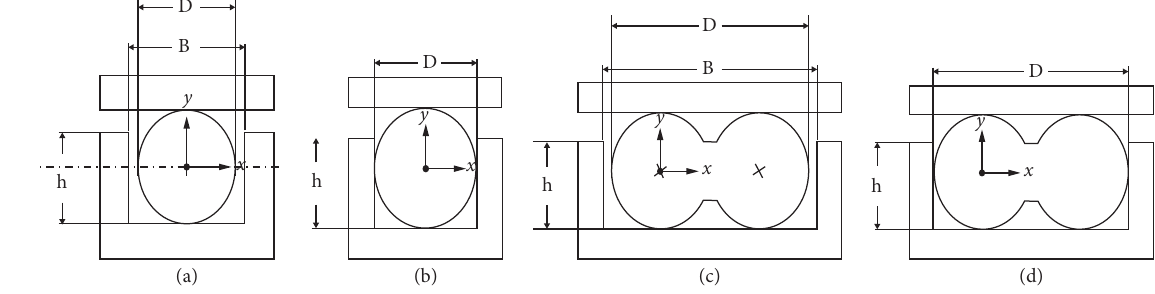
Figure 1: Two-dimensional models of the four seals considered in this